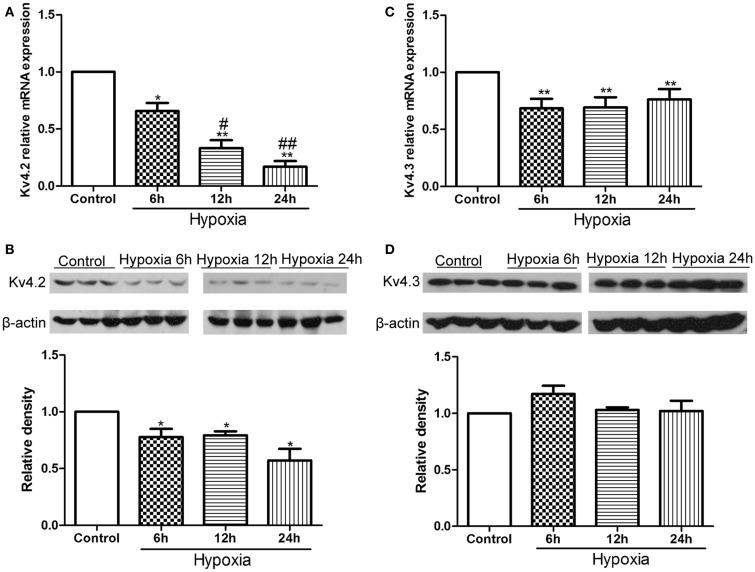
Effect of hypoxia on the mRNA and protein levels of Kv4.2 and Kv4.3. Quantification of mRNA levels of Kv4.2 (A) and Kv4.3 (C). Representative image and quantification of protein levels of Kv4.2 (B) and Kv4.3 (D) in control and hypoxia groups. Equal amounts of collected protein samples were subjected to Western immunoblot analysis. β-Actin was used as an internal control. Data are presented as means ± SEM (n = 3 for protein and mRNA in each group). *p < 0.05, **p < 0.01 vs. control. #p < 0.05, ##p < 0.01 vs. hypoxia 6 h.